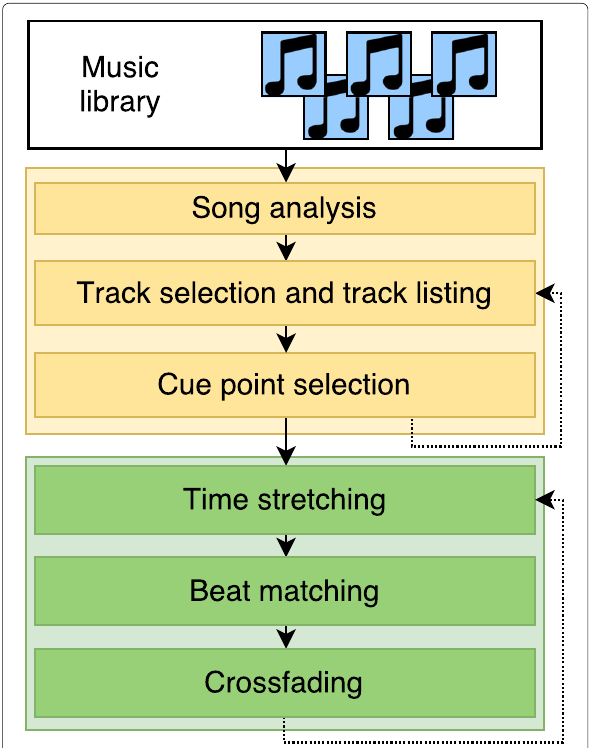
Fig. 1 Illustration of the simplified DJing